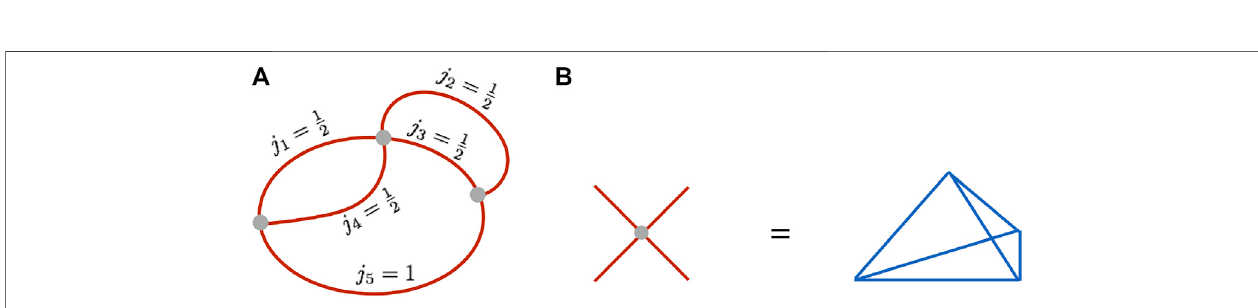
FIGURE 3 | A) An exemplary spin network. (B) In the geometric picture the 4-valent node is dual to a tetrahedron